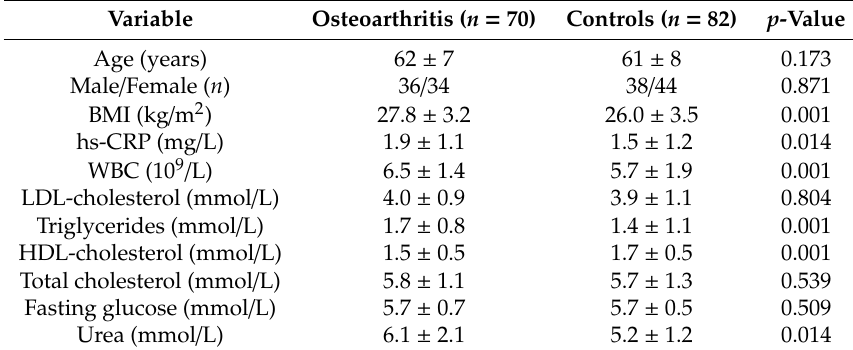
Table 1. General parameters.